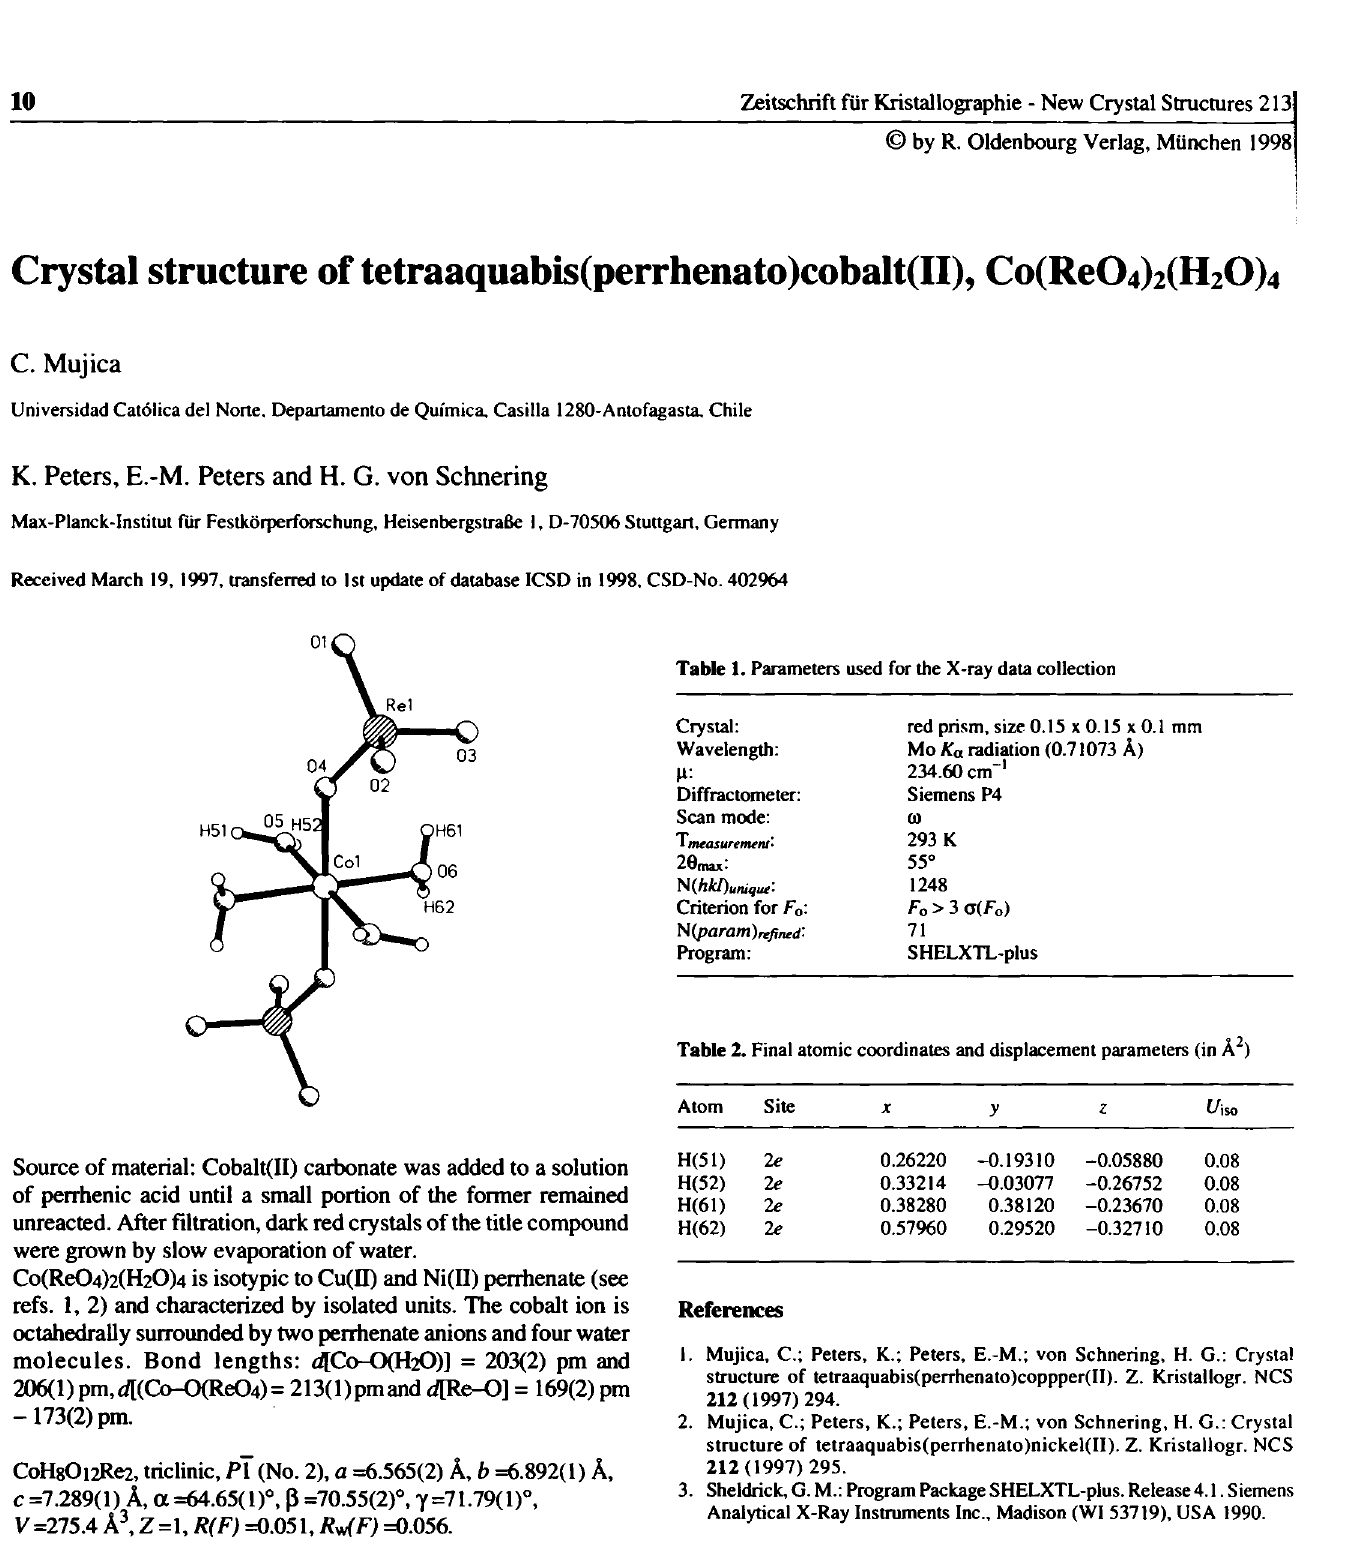
Table 3. Final atomic coordinates and displacement parameters (in A^)